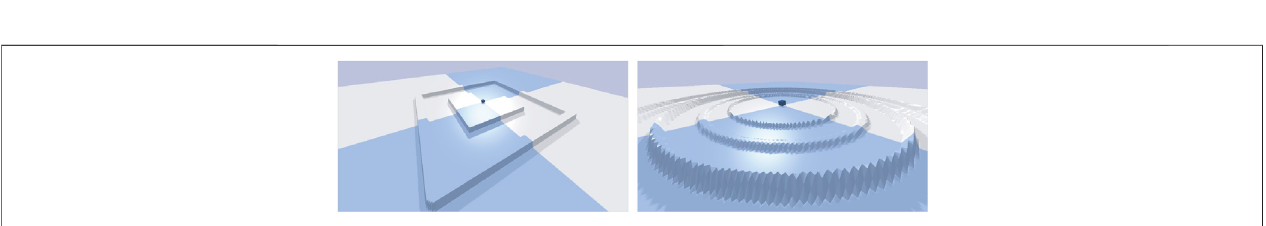
FIGURE 3| The more complexenvironments used to test transferred solutions. On the left the robots start on a raised platform until a ditch is created with a single wide wall. On the right the robots start on a fl at terrain and several circular thin walls ripple outwards becoming taller and taller.